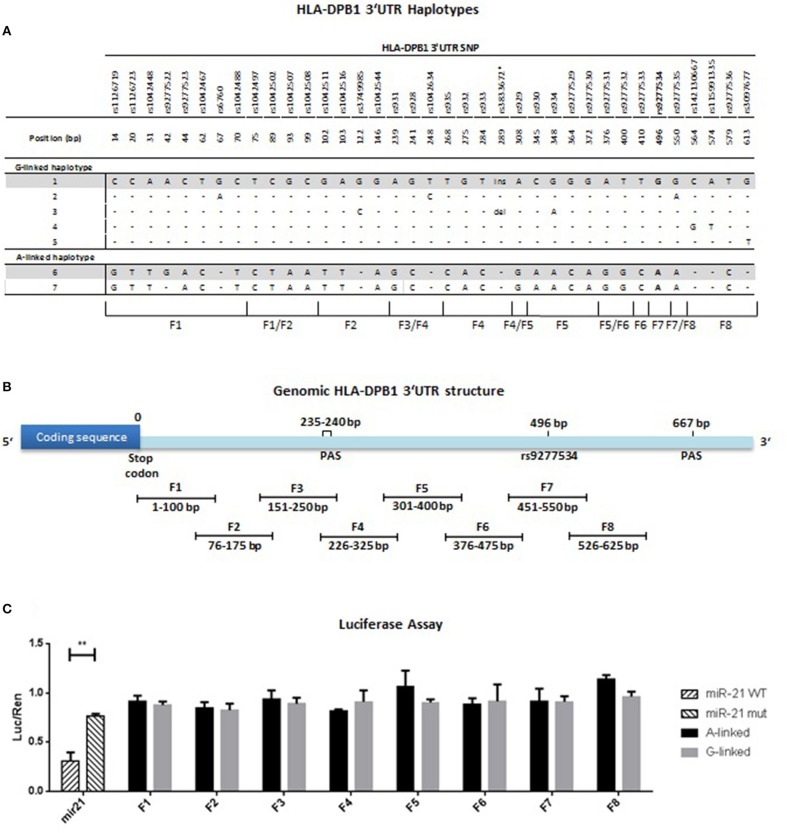
HLA-DPB1 3′UTR haplotype identification, mapping and regulatory activity. (A) 671 bp of the 3′UTR (i.e., from the last 4 bp of exon 5 to the first 667 bp of exon 6) of 30 HLA-DPB1 alleles reported as common in Europe (Table 5) (27) were aligned from the IMGT/HLA database (23). Nucleotide polymorphism was restricted to 37 bi-allelic SNP and one insertion/deletion (ins/del), and is listed with the respective position relative to the stop codon in exon 5. The rs9277534-G/A SNP located at position 496 is indicated in bold. A total of 7 haplotypes were identified, 5 linked to rs9277534-G and 2 linked to rs9277534-A. Nucleotide polymorphism is indicated with reference to the rs9277534-G linked haplotype 1, dashes indicate sequence identity. Haplotypes 1 and 6 were chosen for further studies and are highlighted in gray. (B) Mapping of the HLA-DPB1 3′UTR. Eight overlapping fragments F1-F8, each 100 bp in length with an overlap of 25 bp, were PCR-amplified from haplotype 1 (BLCL AKIBA, HLA-DPB1*09:01) or haplotype 6 (BLCL MOU, HLA-DPB1*04:01) and cloned into the pmirGLO dual luciferase vector as described in Materials and Methods. Note that fragment F7 comprises rs9277534. (C) Gene regulation by HLA-DPB1 3′UTR fragments assessed with the dual luciferase assay. Four different BLCL (APA, MOU, BM21, OSR-6924) were transfected with pmirGLO containing F1-F8 from haplotype 1 (rs9277534-G linked, gray bars) or from haplotype 6 (rs9277534-A linked, black bars), respectively, and tested in 3 independent experiments by dual luciferase assays as described in Materials and Methods. A total of 12 independent analyses were performed for each fragment. 50 bp fragments containing the miR21 WT or mutated target sequence were used as positive and negative control, respectively (striped bars). Results are expressed as mean of fold-change of luciferase activity respect to renilla (luc/ren). Bars refer to SD between 12 independent experiments. Statistical comparisons were performed by the Wilcoxon matched-pairs signed rank Test (**p < 0.001).